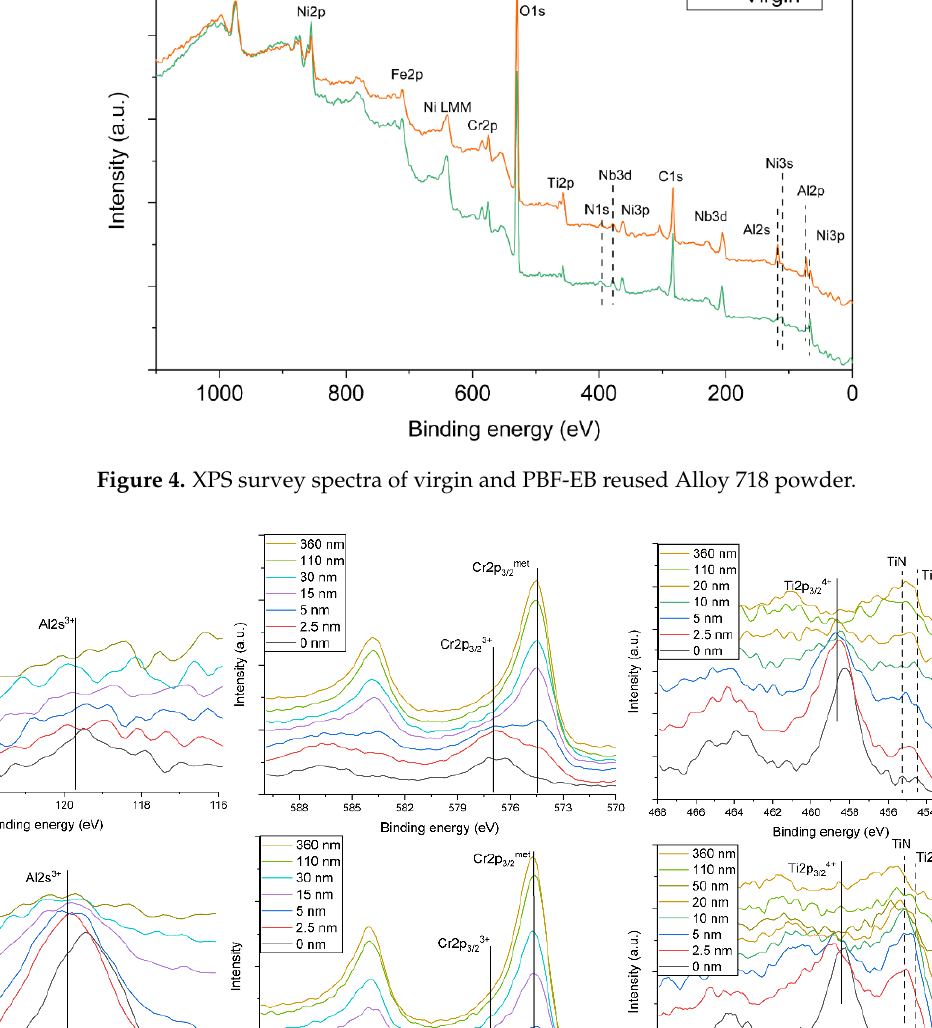
Figure 6. Comparison of ( a ) variation in normalized oxygen intensity with etched depth and ( b ) average oxide particulate/layer thickness for virgin and reused powder calculated by using O1s spectra. Depth is measured relative to the etch rate of Ta 2 O 5 , which was used to calibrate the etch rate. 3.4. Rheological Behavior The rheological behavior of metal powders plays a key role in successful application of the thin layer prior to sintering and melting in PBF-EB [19]. Thus, the packing density of the powder layer will enable a full contact between particles for higher electrical con- ductivity, which leads to successful melting. Spreadability of the thin powder layer is